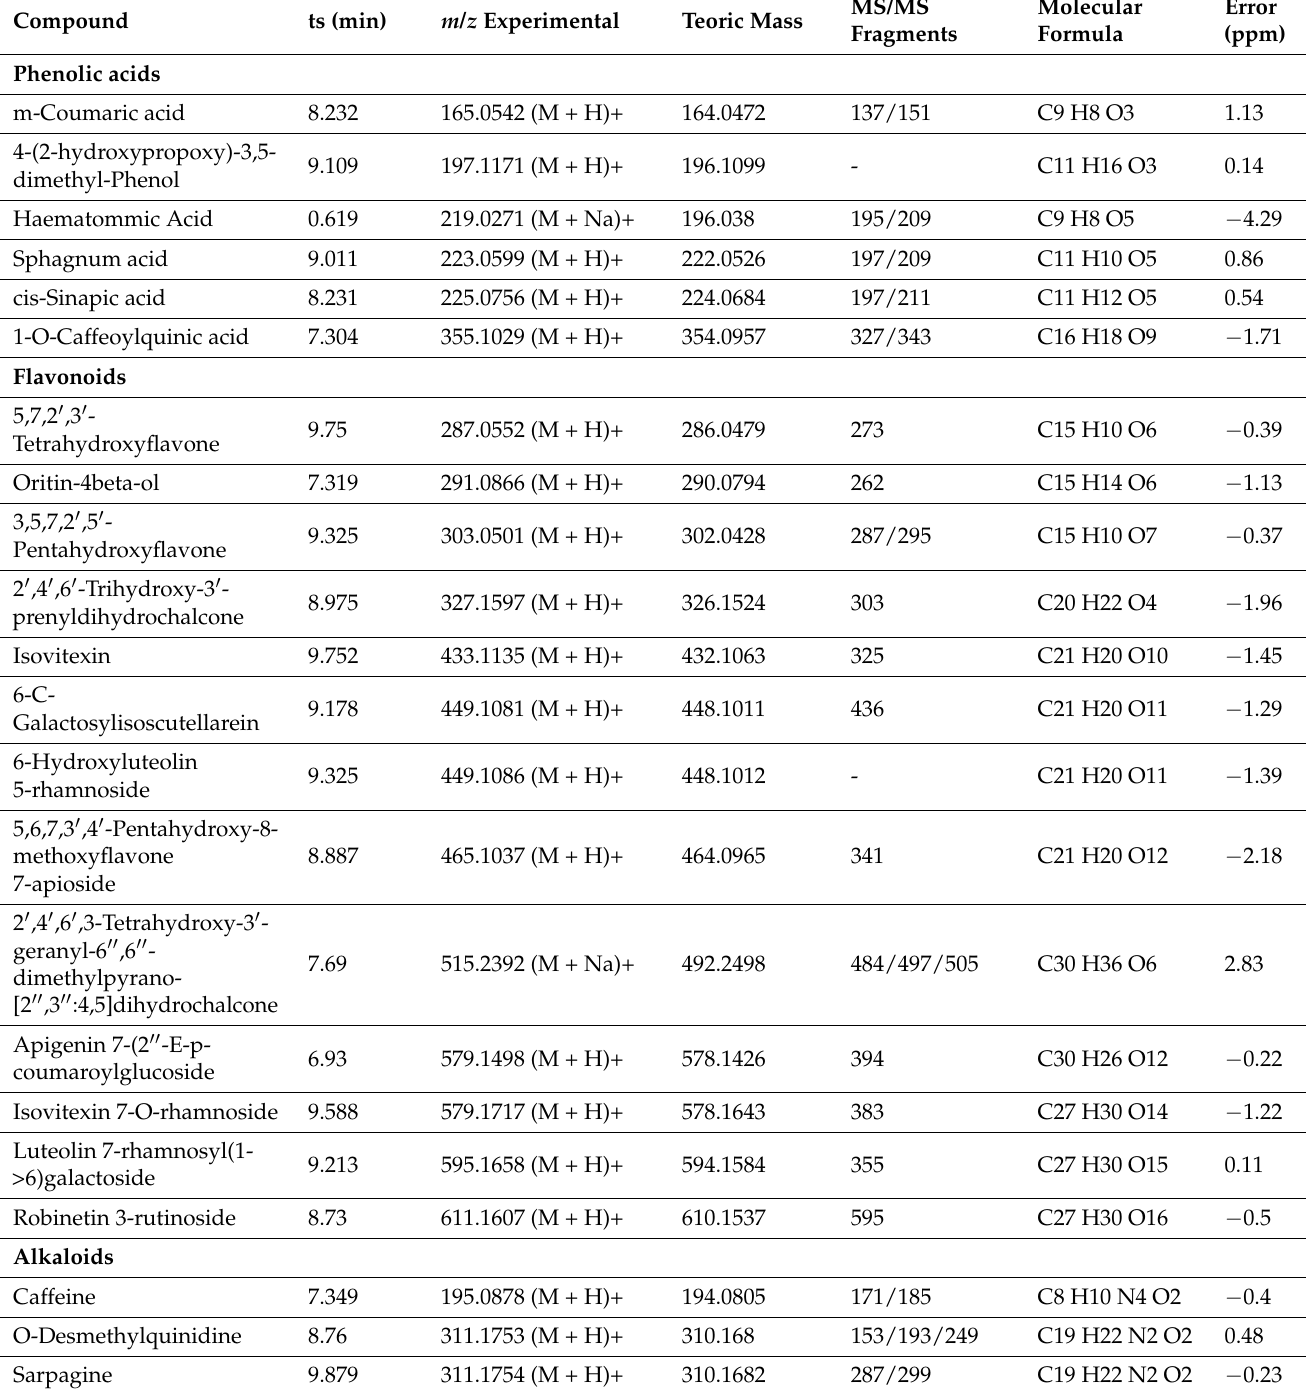
Table 5. Phytochemical profile of the 60% methanolic extract of A. angustiloba leaves by LC–MS in the positive ion